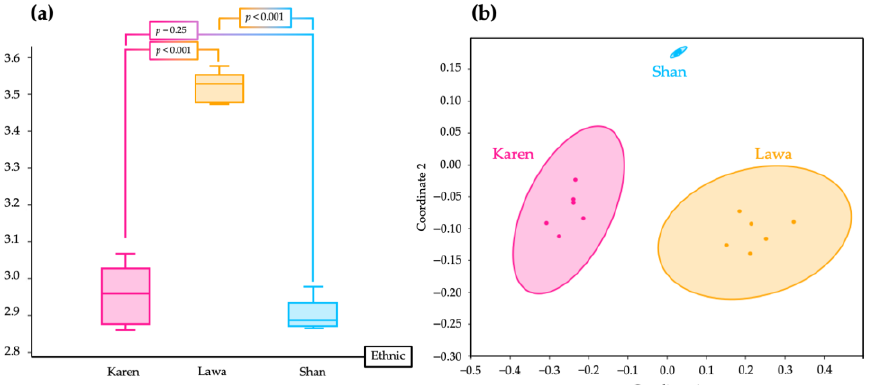
Figure 4. Boxplot of alpha diversity indicated by the Shannon index, which shows some similarities in bacterial diversity between the FSBs of the Karen and the Shan ( p = 0.25), but differences in bacterial diversity between those of the Karen and the Lawa ( p < 0.001), and between those of the Lawa and the Shan ( p < 0.001). Bacterial diversity in the Lawa FSB was greatest among the FSBs from the three ethnic groups ( a ). The NMDS plot shows the differences in bacterial taxa and quantity among the FSBs of the three ethnic groups with separated circles of 95% ellipses ( b ).